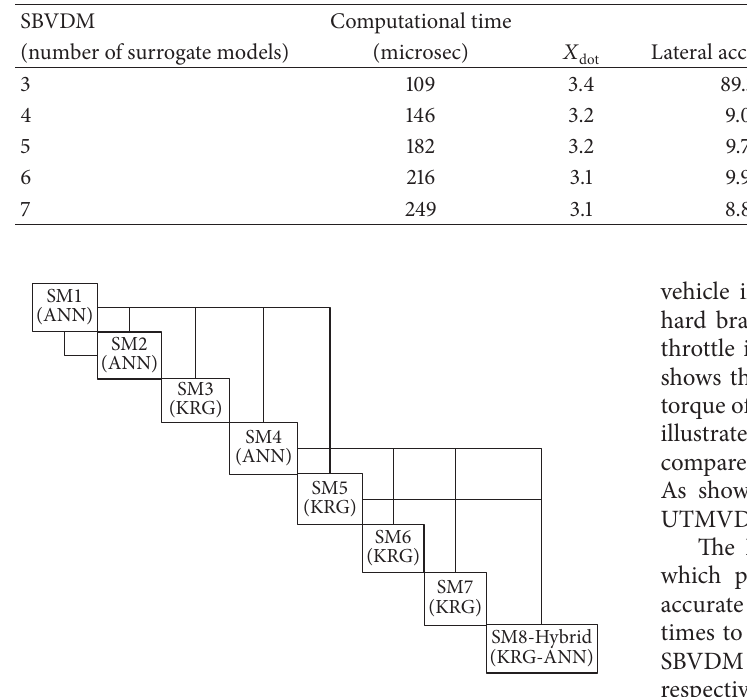
Figure 8: SBVDM developed with 8 surrogate